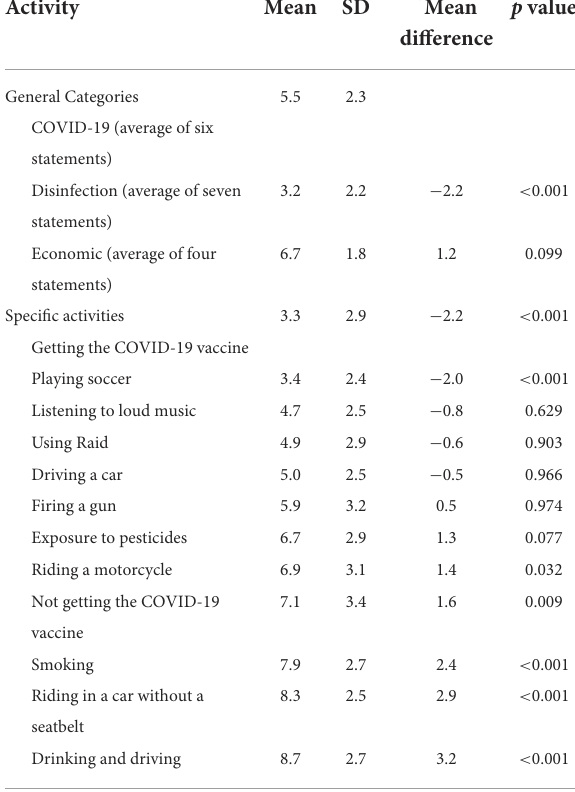
TABLE 3 Summary of perceived risk score of COVID (average of six statements) relative to other activities on a Likert scale from 1 (very low risk) to 10 (extremely